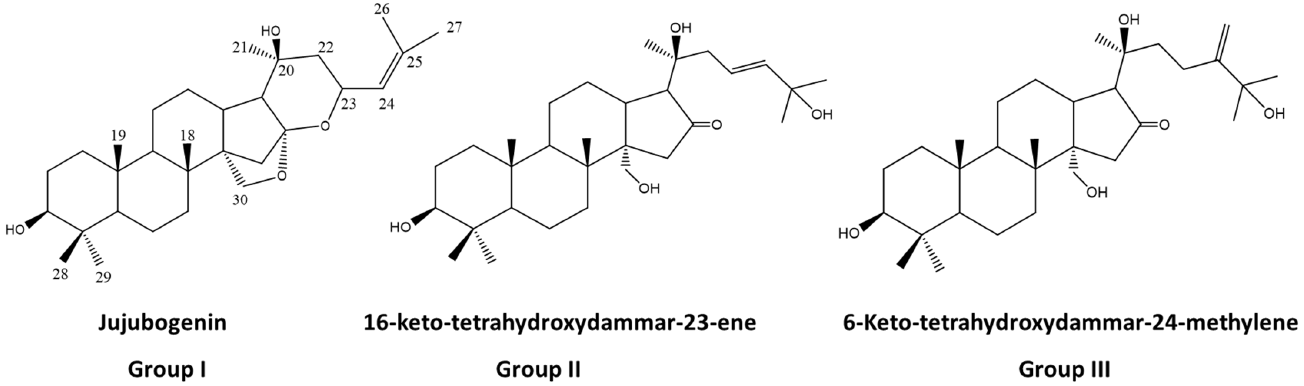
Figure 5. Main aglycones of saponins from Ampelozizyphus amazonicus.